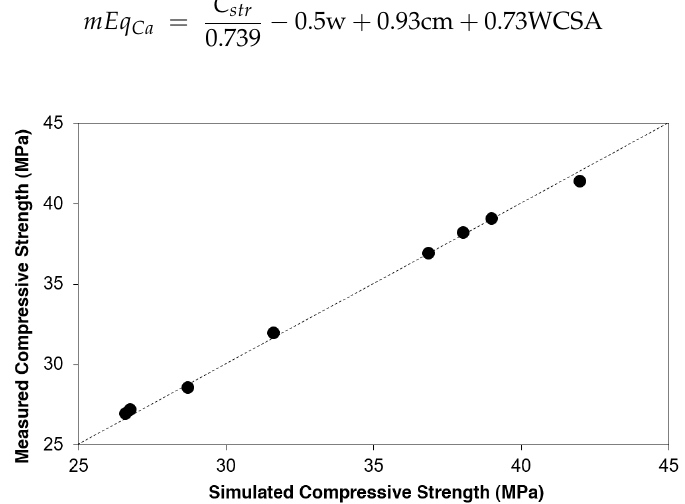
Figure 5. Observed vs. predicted compressive strength adopting Equation (2).